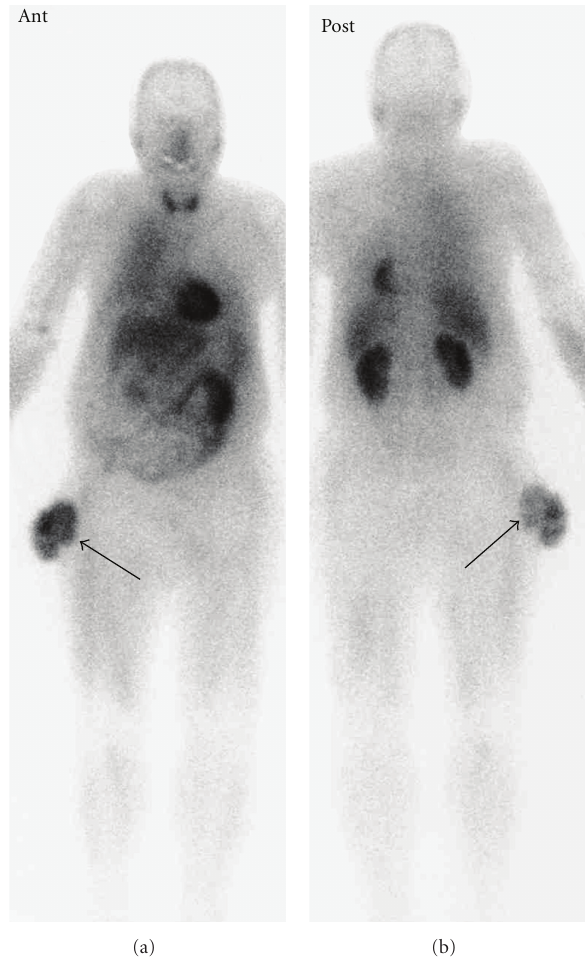
Figure 3: Thallium-201 scintigram of whole body in early phase. Abnormal accumulations accorded for the mass were detected (black